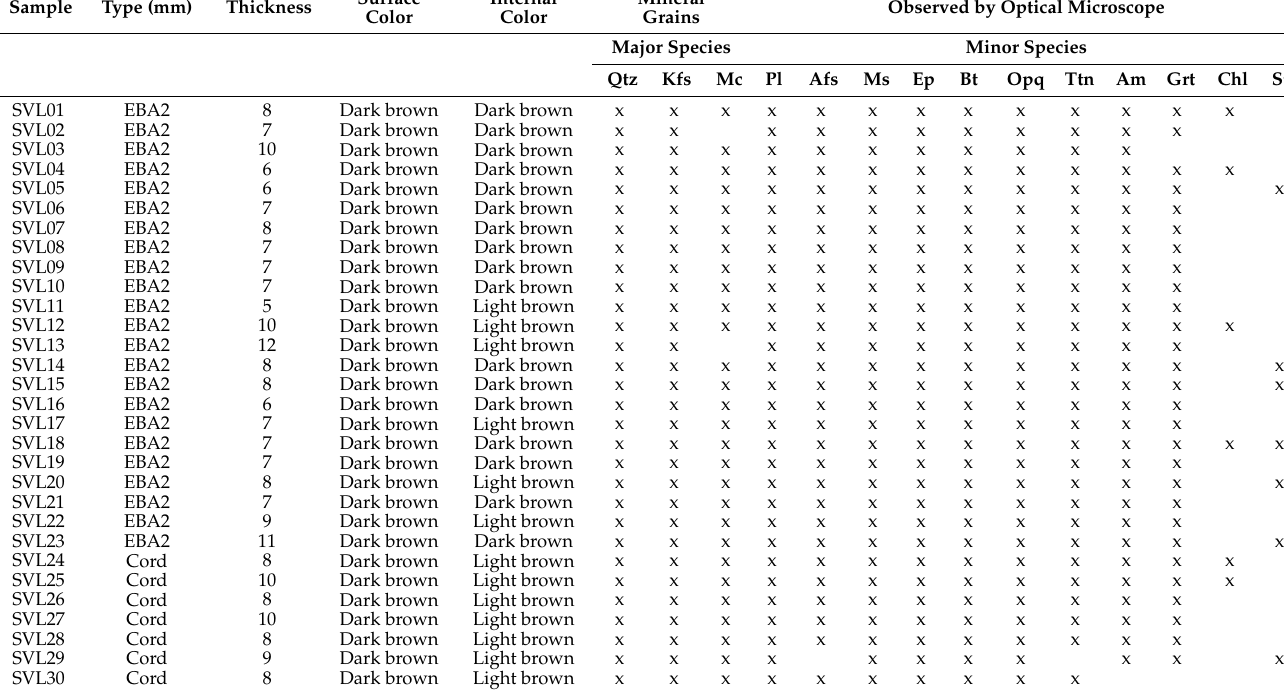
Table 1. Descriptions of pottery samples studied and mineral grains in the samples. Abbreviations: EBA2—local-made pottery at the second stage of the EBA (EBA2); Cord—pottery with cord decora- tion; Qtz—quartz; Kfs—potassium feldspar; Mc—microcline (potassium feldspar); Pl—plagioclase; Afs—alkali feldspar; Ms—muscovite; Ep—epidote; Bt—biotite; Opq—opaque minerals; Ttn—titanite; Am—amphibole; Grt—garnet; Chl—chlorite;